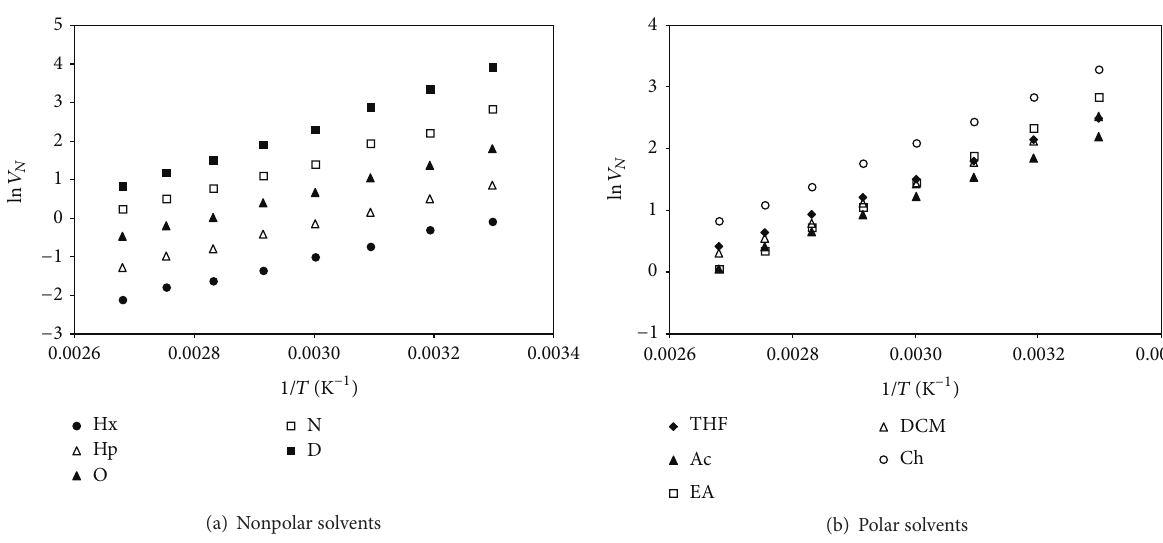
Figure 4: The retention diagrams, 𝑉 𝑁 , of (a) nonpolar solvents and (b) polar solvents adsorbed onto